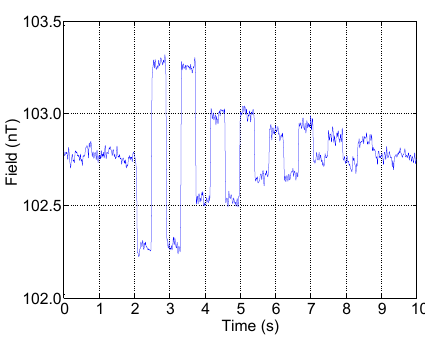
Fig. 9. Time series showing two cycles, each of square waves at amplitudes of 1, 0.5, 0.25, and 0.125nT respectively. Data is post-processed with a 1Hz low-pass filter to remove environmen- tal 60Hz noise.